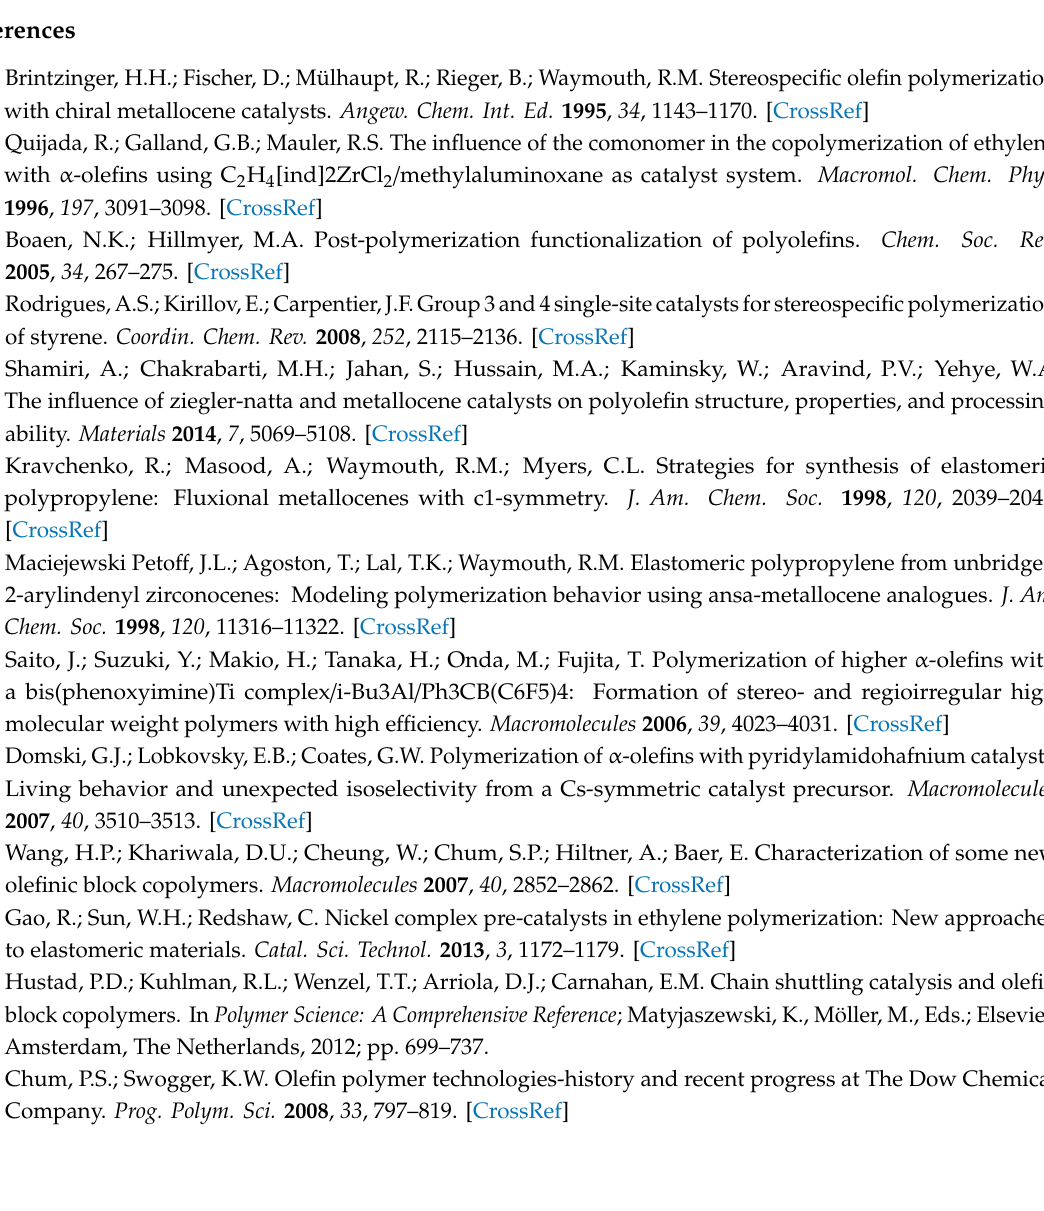
filtrate (tested under humid aerobic conditions). Figure S2: The DSC curves of the typical copolymers: poly(propylene- co -1-hexadecene)s and other poly(propylene- co - α -olefin)s with various α -olefin incorporation. Figure S3: Stress-strain curves of the typical copolymers: poly(propylene- co -1-octene)s and other poly(propylene- co - α -olefin)s with similar comonomer incorporation (~12 mol.%). Figure S4: Cyclic tensile test curves of poly(propylene- co - α -olefin) with similar comonomer incorporation (~12 mol.%) under a maximum strain from 50% to 1200%. Figure S4: Cyclic tensile test curves of poly(propylene- co - α -olefin) with similar comonomer incorporation (~20 mol.%) under a maximum strain from 50% to